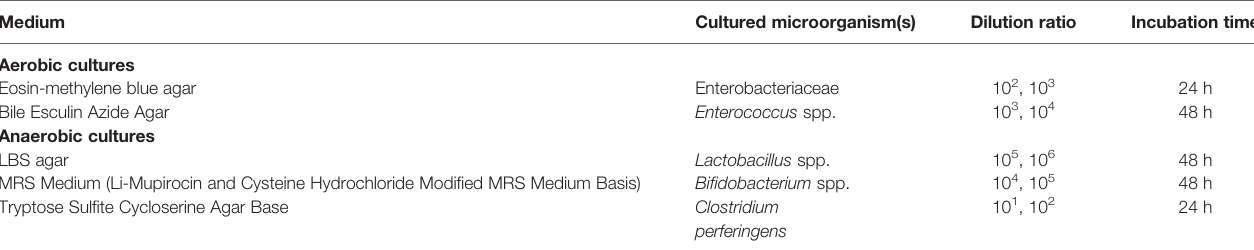
TABLE 1 | Media and cultivation conditions used for enumeration of microorganisms.